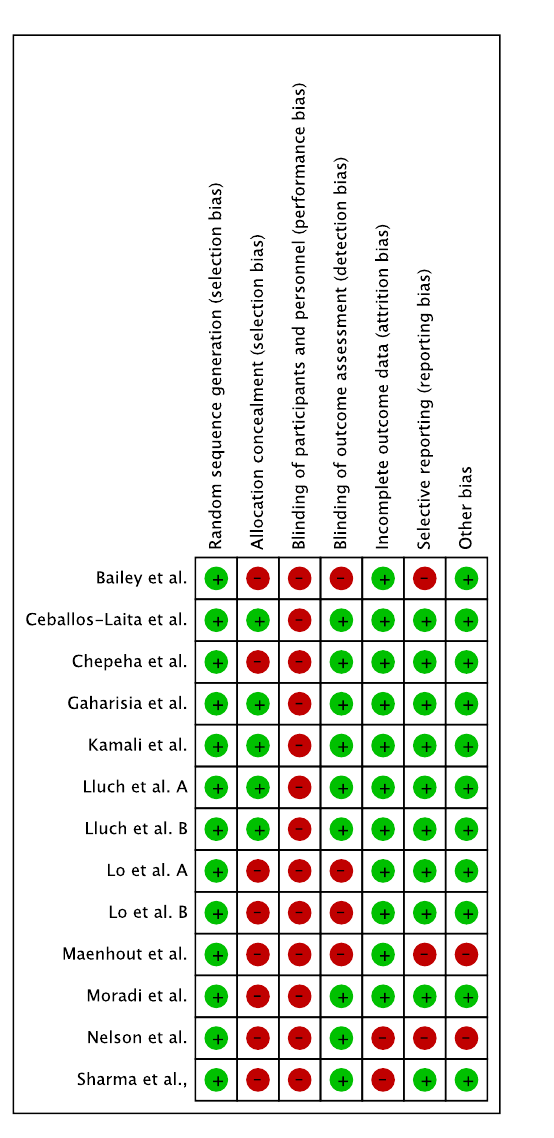
Figure 2. Risk of bias. + = Low risk of bias, - = High risk of bias. ( A ) Presents the Risk of bias of all the studies according to the Cochrane Tool Risk of Bias items. ( B ) Shows the Risk of bias specifically of each study according to the Cochrane Tool Risk of Bias items.